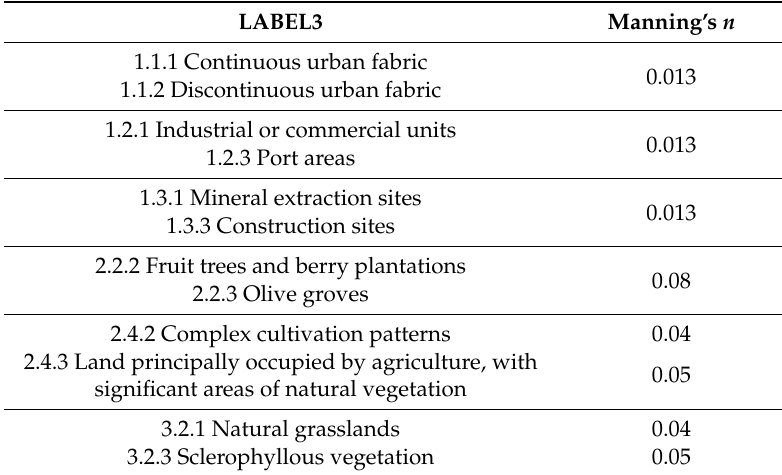
Table 2. Study area of Manning’s roughness coe ffi cient based on CORINE land cover data [5].